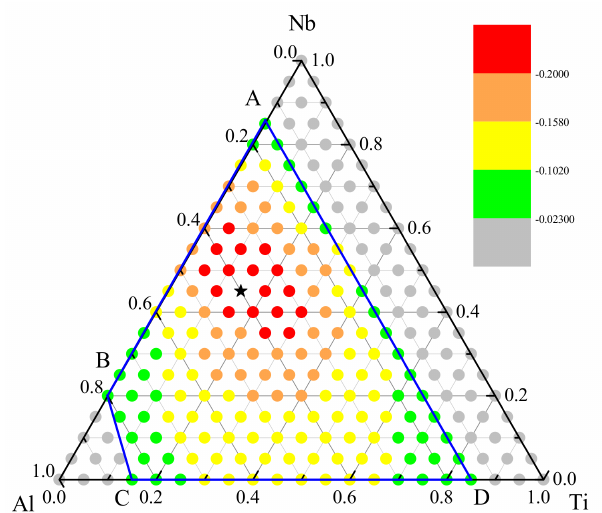
Figure 4. The amorphous driving force (eV/atom) of Ti-Nb-Al solid solutions in the predicted GFR. The black pentagram indicates the alloy with the largest glass-formation ability